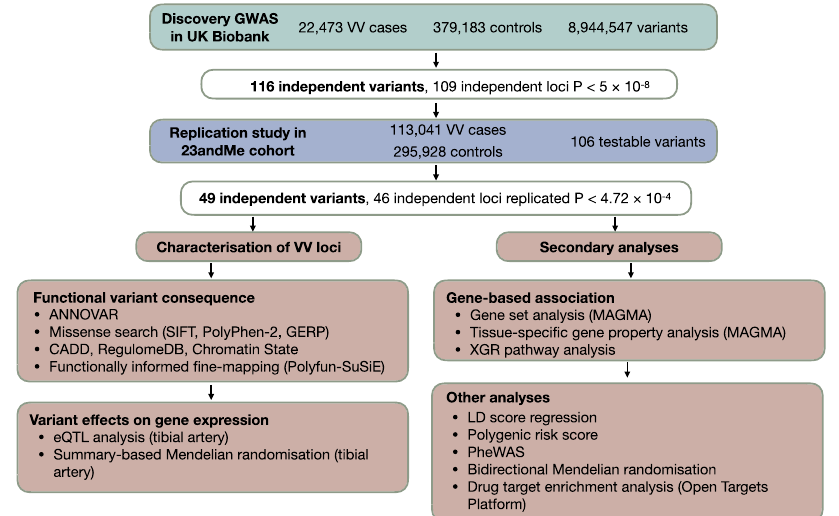
Fig. 1 Study design and analysis work fl ow. A discovery GWAS was performed in the UK Biobank cohort, with the top independent lead variants tested within the 23andMe replication cohort. Forty-nine independent variants at 46 loci met the Bonferroni-corrected threshold in the replication cohort, and were interrogated further in subsequent analyses.